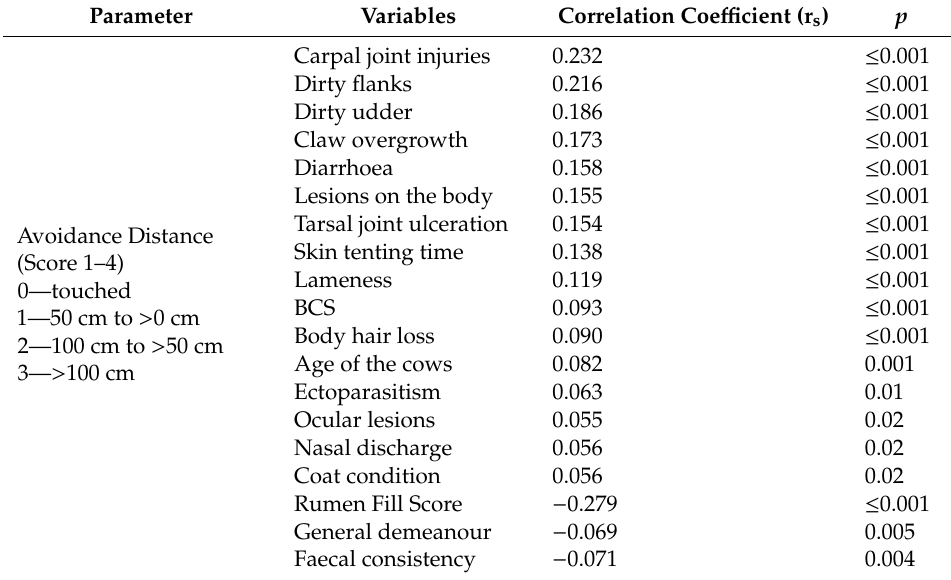
Table 3. Spearman’s rank correlations between avoidance distance scores for each cow ( n = 1620) and cow-based welfare